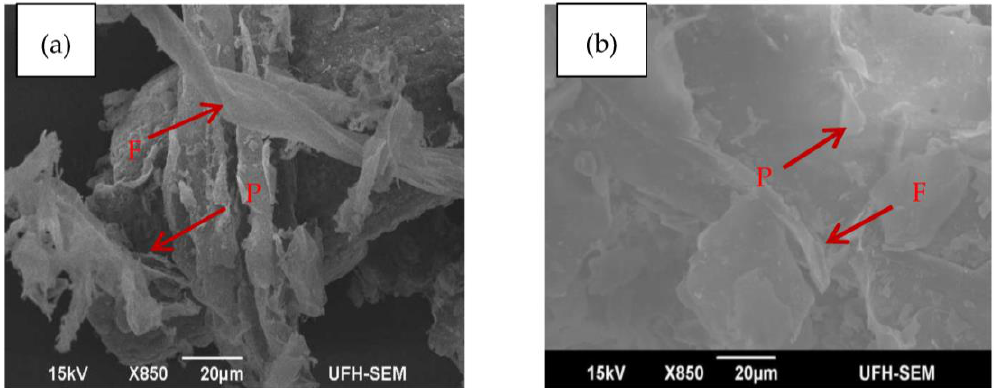
Figure 6. SEM images of SCB obtained under the same analysis condition with: ( a ) torrefied; and ( b ) untorrefied.